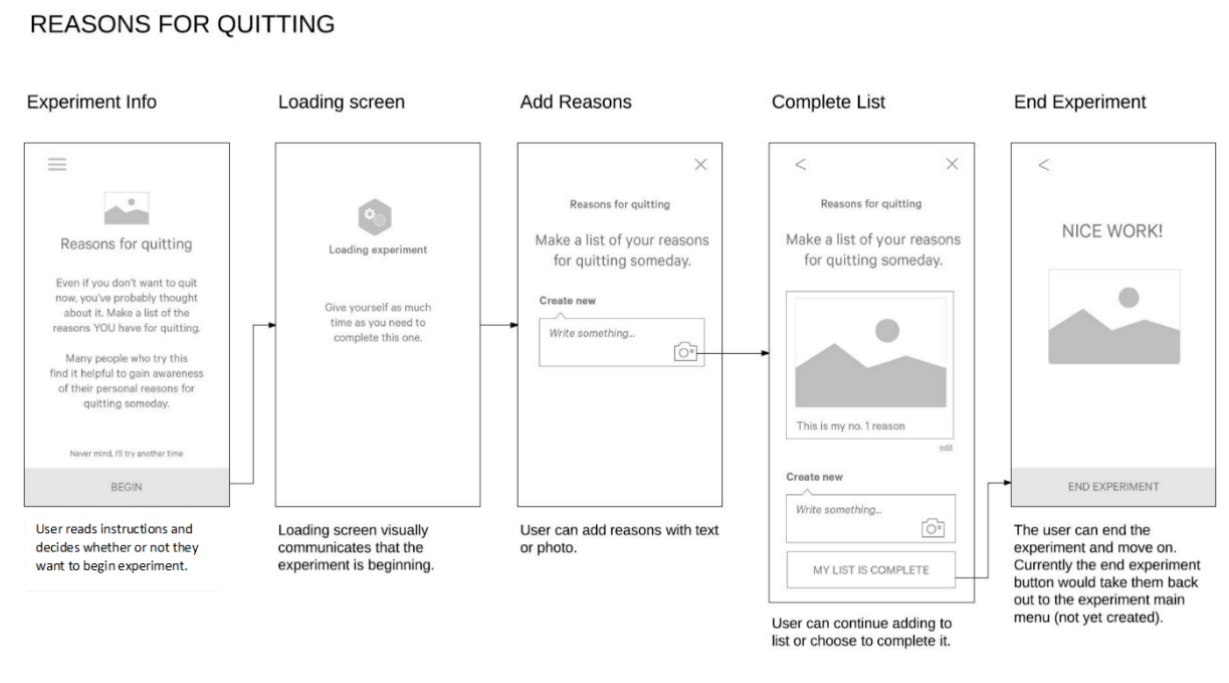
Figure 2. Example of a low-fidelity prototype of a personal